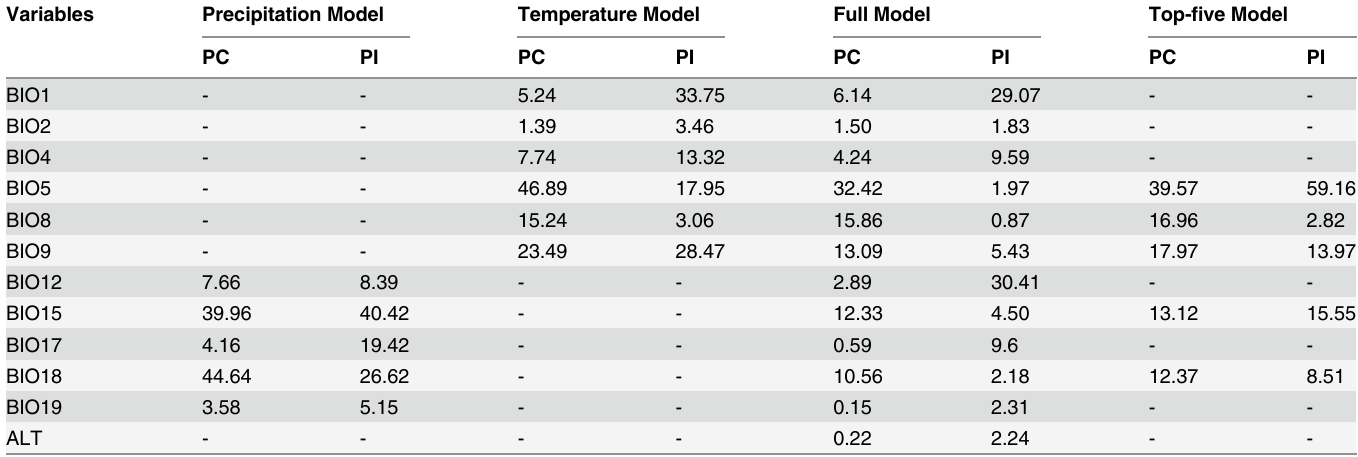
Table 3. Summary of environmental variables, of the average percent contribution (PC) and permutation importance (PI) for each of the four spe- cies distribution models of O . turicata .